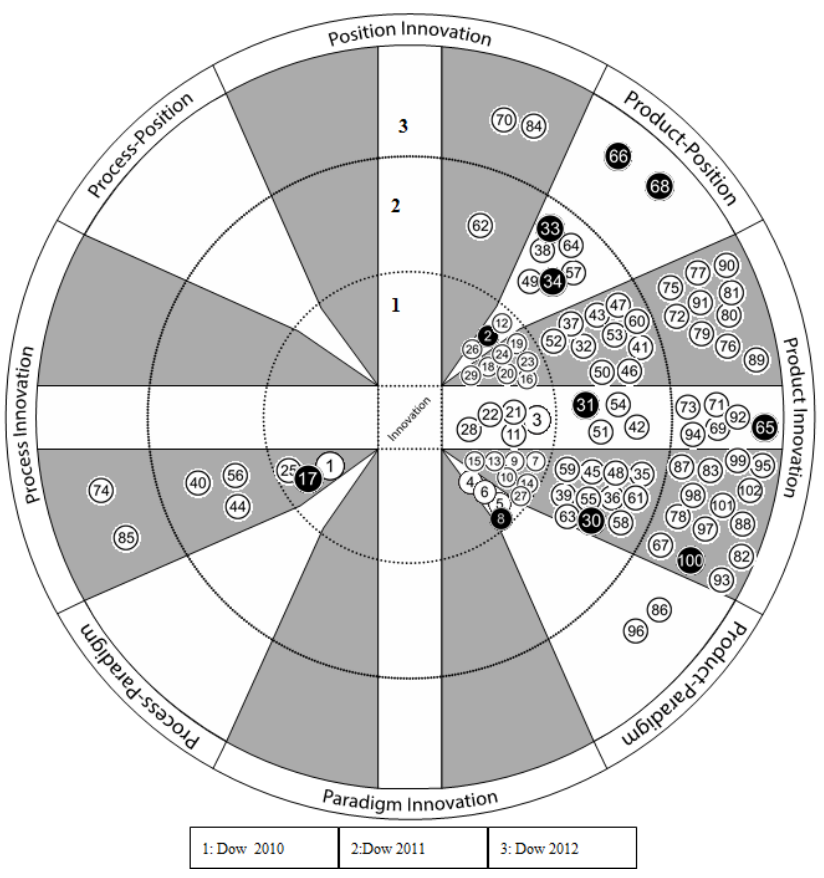
Fig. 5. Mapping Innovation of Dow Chemical from 2010 to 2012